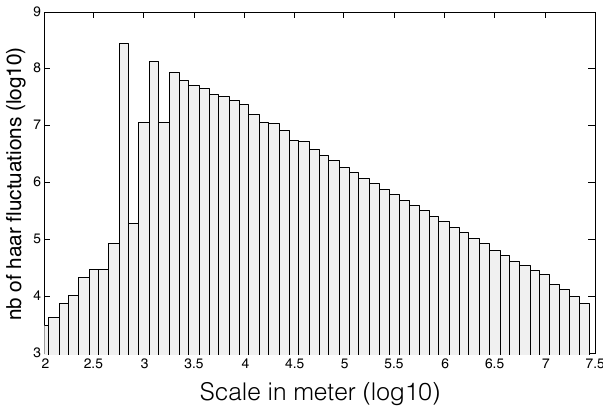
Figure A4. Distributions of Haar fluctuations depending on the